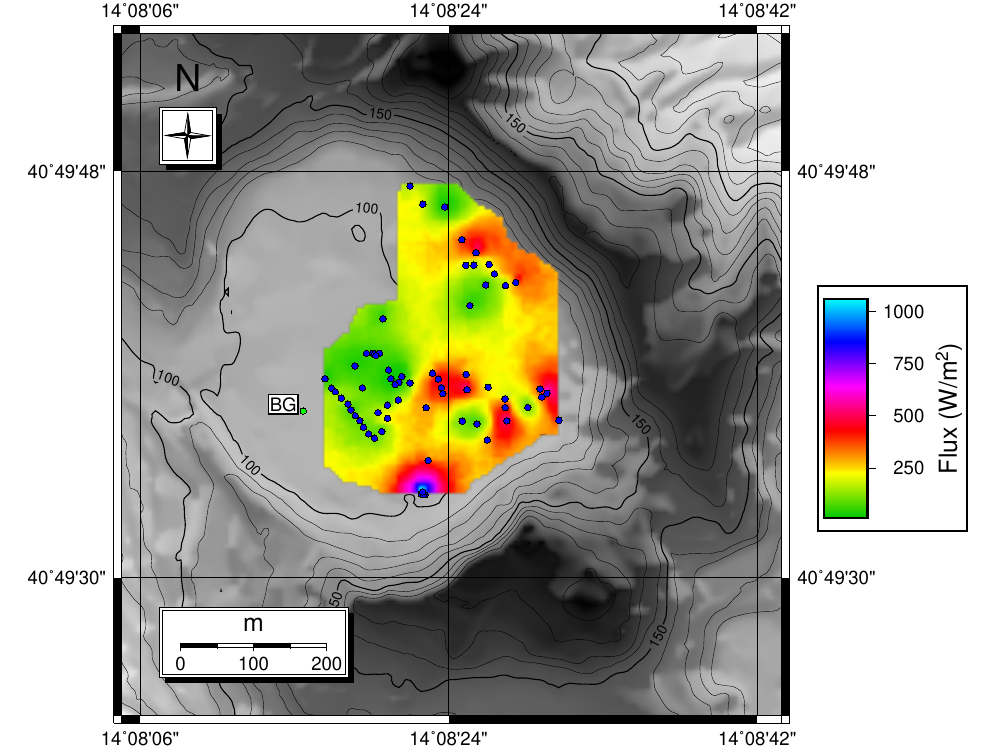
Figure 7. Map of the calculated heat flux distribution over the investigated area using points sampled during nights (blue dots). The green dot represents the background point (BG)